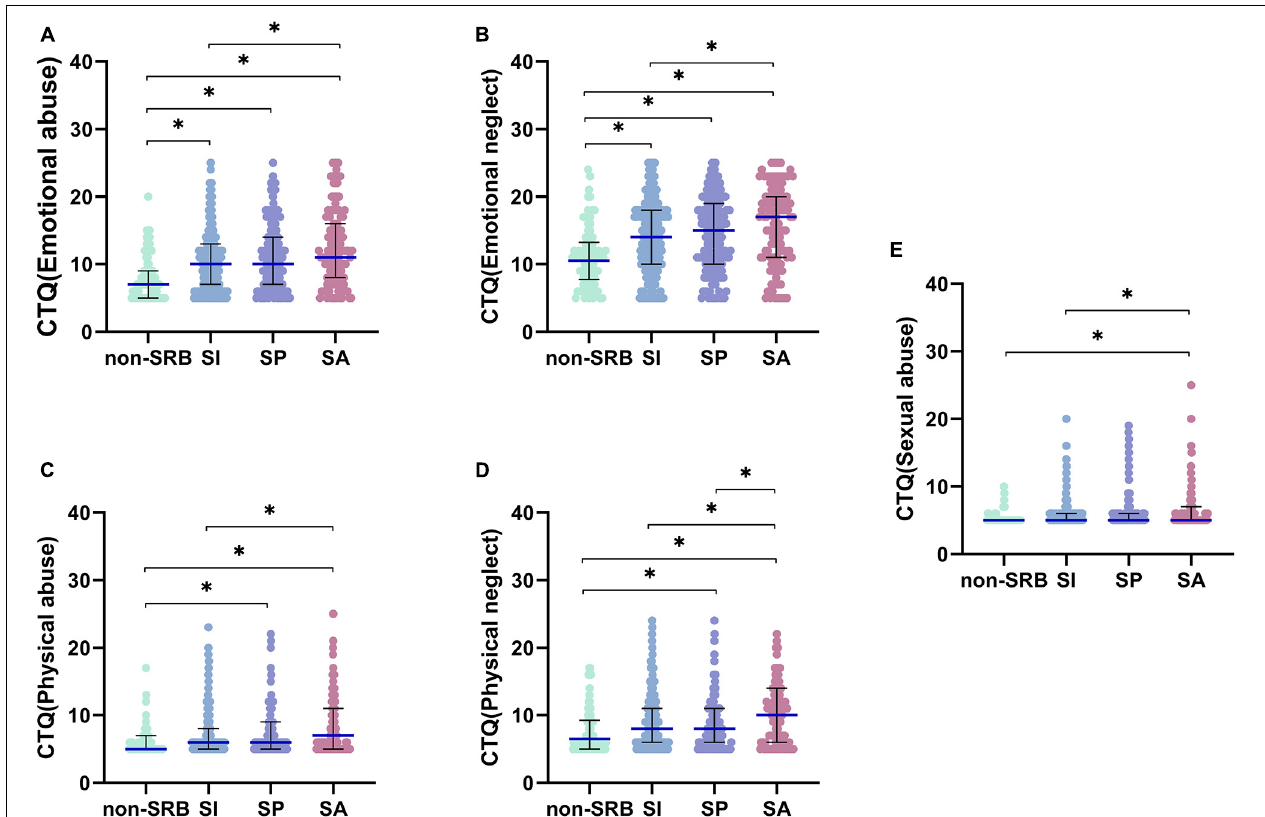
FIGURE 3 | Pairwise comparison of childhood abuse. (A) Emotional abuse of childhood abuse. (B) Emotional neglect of childhood abuse. (C) Physical abuse of childhood abuse. (D) Physical neglect of childhood abuse. (E) Sexual abuse of childhood abuse. ∗ P < 0.05. Non-SRB, group without suicide-related behavior; SI, group with suicidal ideation; SP, group with suicidal plan; SA, group with suicidal